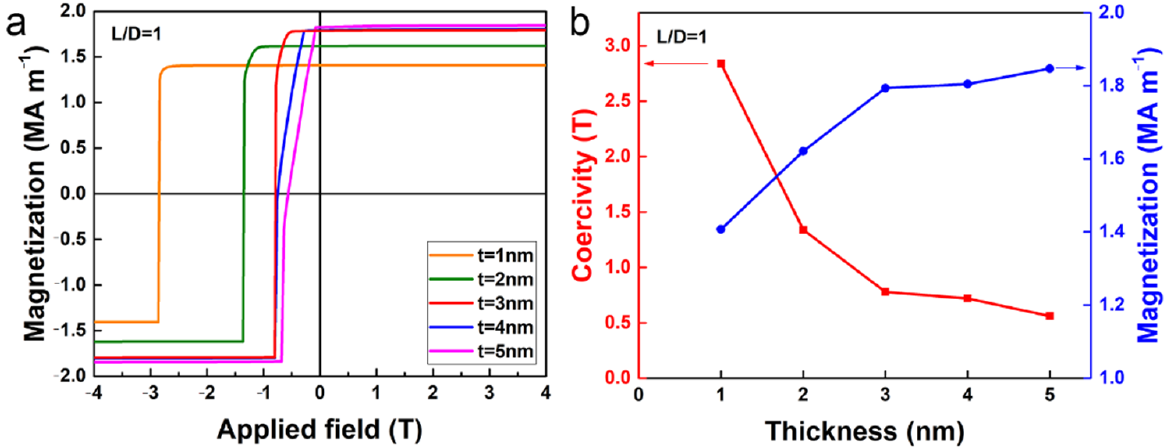
Figure 2. ( a ) Calculated demagnetization curves of the core/shell cylinder for different thicknesses of soft magnetic shell t , with aspect ratio L / D = 1. ( b ) The intrinsic coercivity (red) and saturation magnetization (blue) of the core/shell cylinder shown as a function of t . To gain an in-depth fundamental understanding of the magnetic reversal, we system- atically investigated the effect of soft magnetic shell thickness on the magnetic structure evolution during demagnetization. The magnetic structures of different soft magnetic shell thickness prior to coercivity of the core/shell cylinder with L / D = 1 are shown in Figure 3. As can be seen, the magnetic reversal with different soft magnetic shell thickness exhibits three different characteristics. For the cases of t = 1 nm and t = 2 nm, the magnetic reversal begins at the soft magnetic shell, and the magnetization reversal mode is coherent rotation. When t = 3 nm, magnetization reversal occurs in a quasi-coherent rotation, where the partial magnetic moments of the fringe are tilted. However, when t reaches above 4 nm, the magnetization reversal mode evolves into curling [8]. The magnetization reversal mode is determined by the competition between the exchange energy and the demagnetization energy [30]. Generally, the magnetic particles with large size tend towards a reversal in a curling mode, which results in no demagnetization. As the size decreases, the exchange energy density increases, owing to the increase in the relative angle between neighboring magnetic moments. When the size falls into a coherence radius, they tend towards a reversal in coherent-rotation